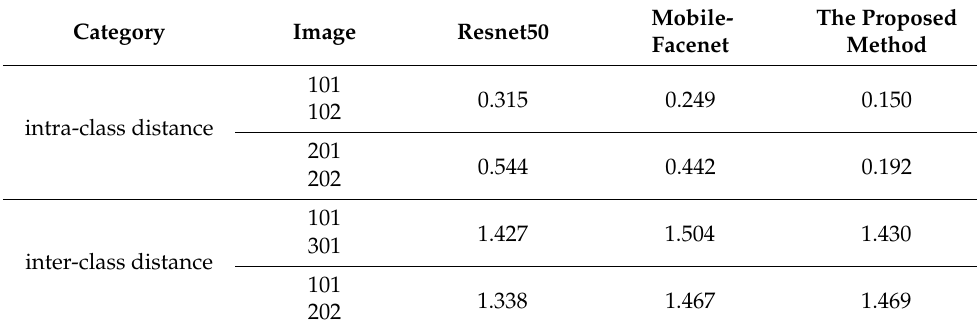
Table 4. Performance comparison of different algorithms.